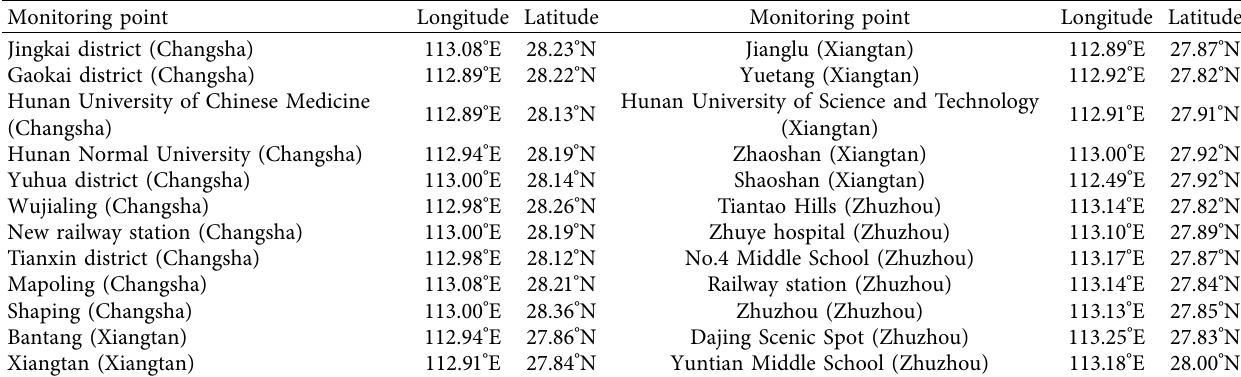
Table 1: Longitude and latitude of the air quality monitoring points in the